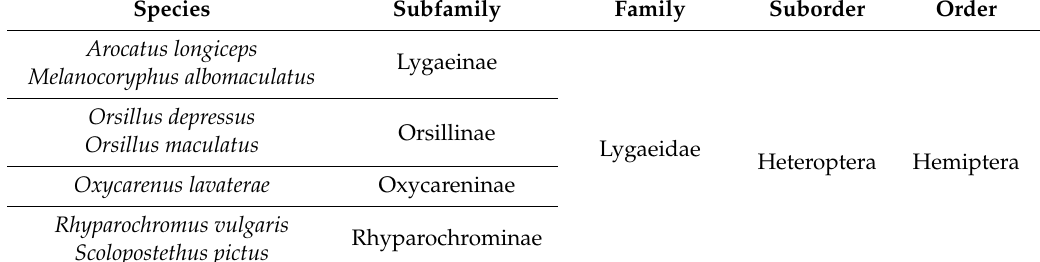
Table 1. Bug species sampled and their systematic order [6,43].